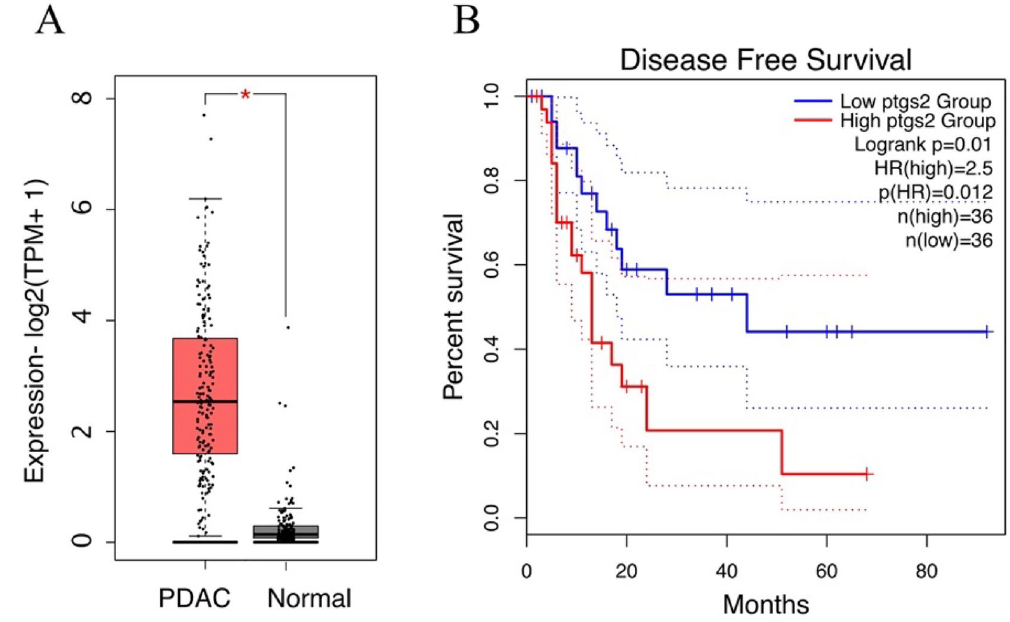
Figure 6. PTGS2 is highly expressed in PDAC and is associated with disease free survival. ( A ) The expression profile of PTGS2 from the TCGA Research Network (http:// cance rgeno me. nih. gov/). Data were presented by box plots. n = 179 for PDAC tissues and n = 171 for adjacent normal tissues. TPM, transcripts per million ( B ) Kaplan–Meier survival curves comparing PDAC patients with high (80%) and low (20%) expression of PTGS2. HR, hazard